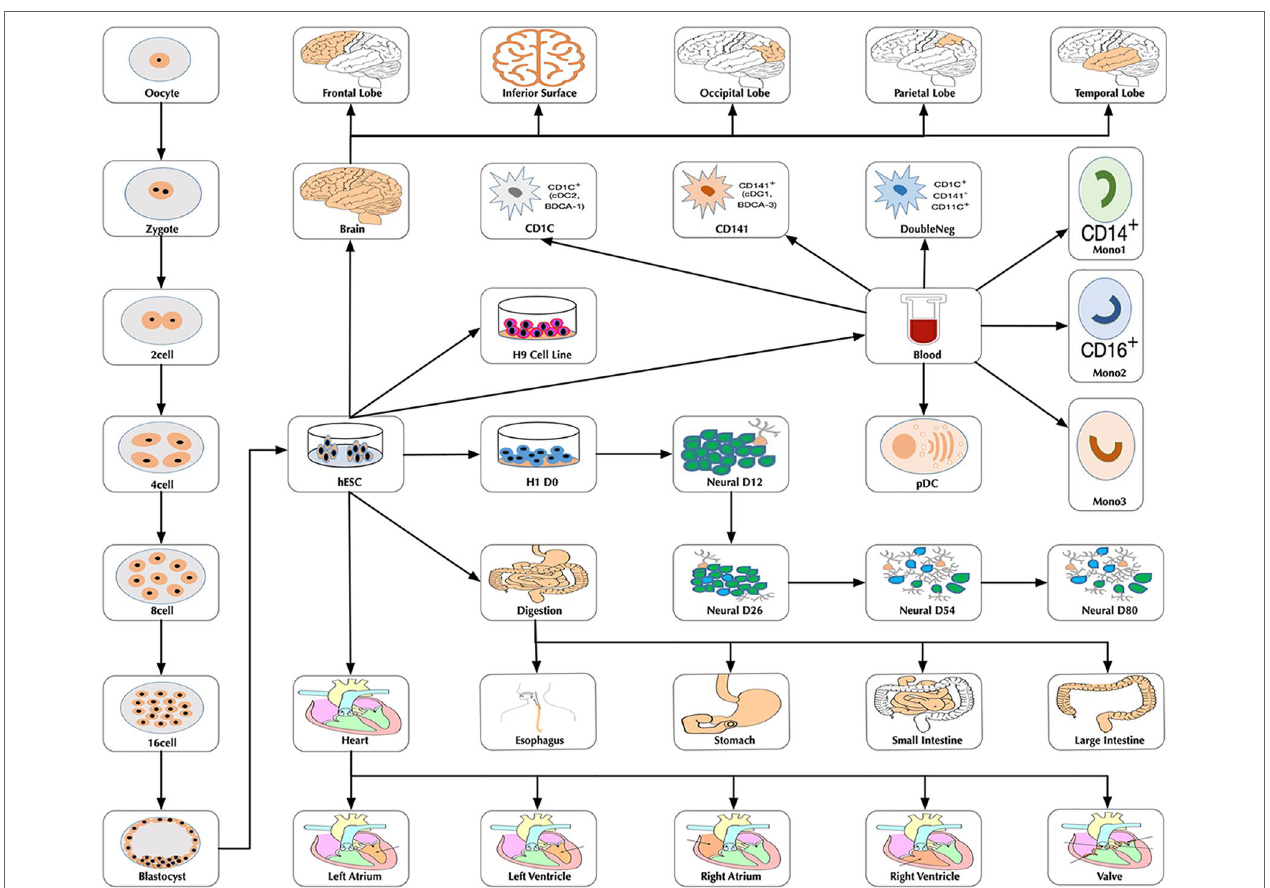
FIGURE 1 | The developmental tree. Figures of the brain, heart and digestion originate from Wikimedia Commons (https://commons.wikimedia.org/wiki/Main_Page).